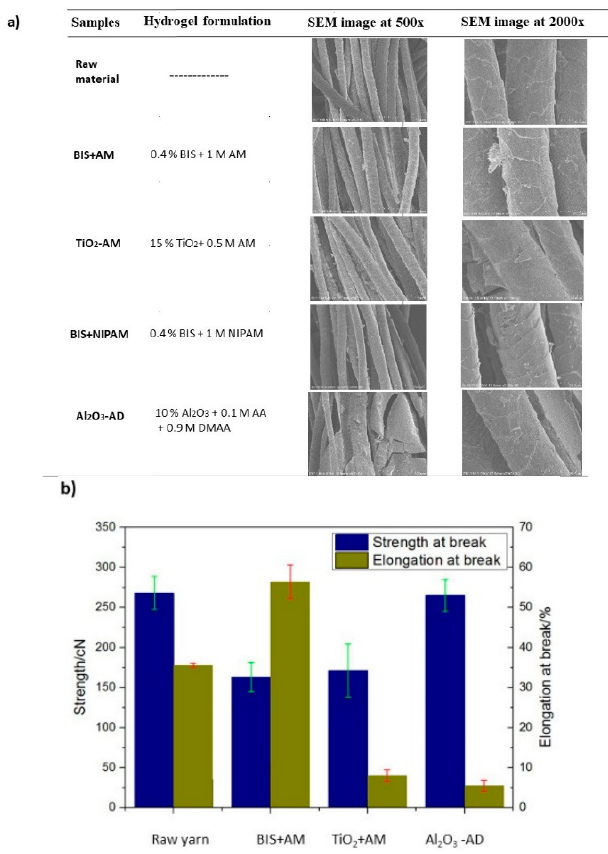
Figure 3. ( a ) SEM microphotographs at 500× and 2000× magnification of hydrogel-coated wool yarn using different hydrogel precursor formulations; ( b ) Strength and elongation of hydrogel-coated wool yarns.